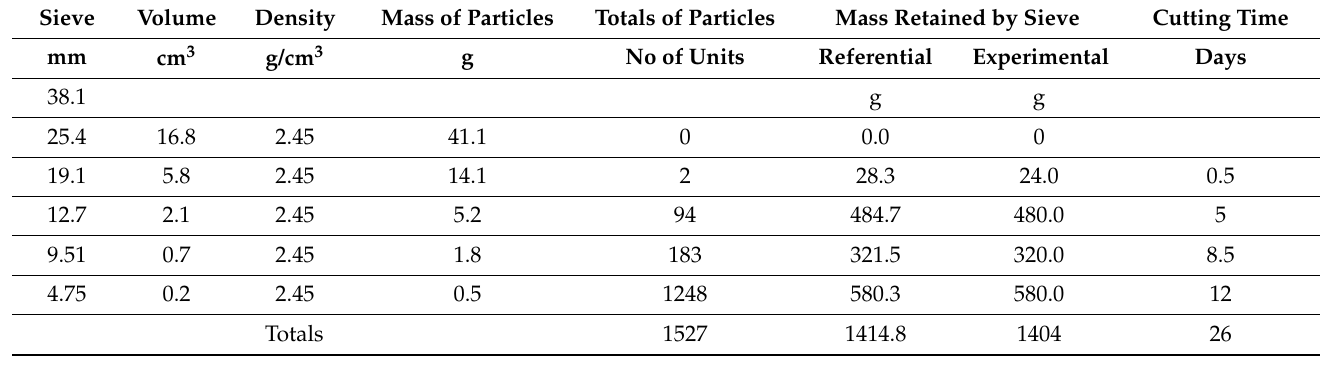
Figure 1. Sequence of transformation activities: ( a ) original rocks of limestones, ( b ) cutting cores for mechanical and elastic tests, ( c ) laminar cutting of rock, ( d ) spherical shaping of particles, and ( e ) grouping of shaped particles to make a cylinder of 100 mm × 200 mm. Table 1. Particles that needed to be generated at the time in the computational model.